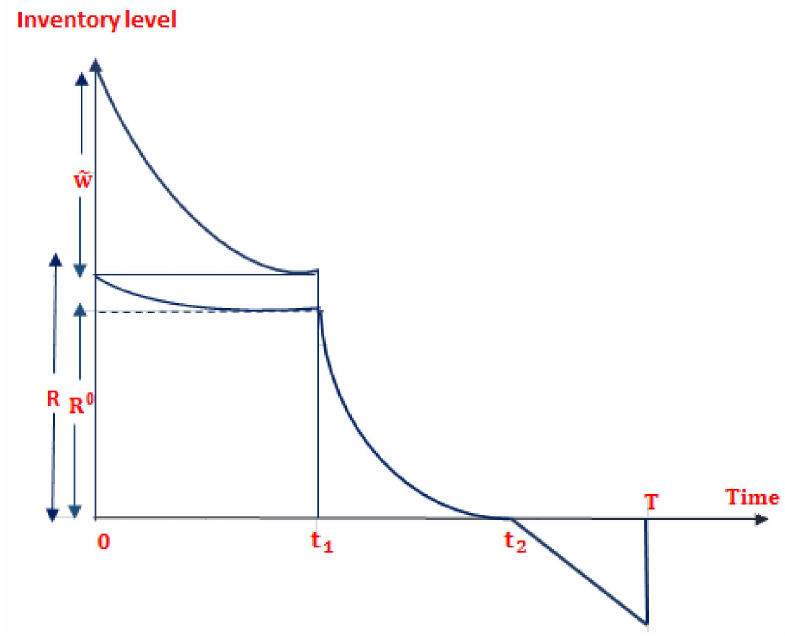
Figure 3. FIFO policy depicted